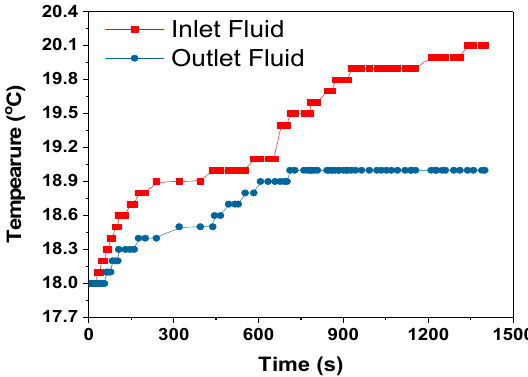
Figure 15. The coolant temperature variation measured at the inlet and outlet of the heat exchanger during the 2C wet discharge of the battery module.